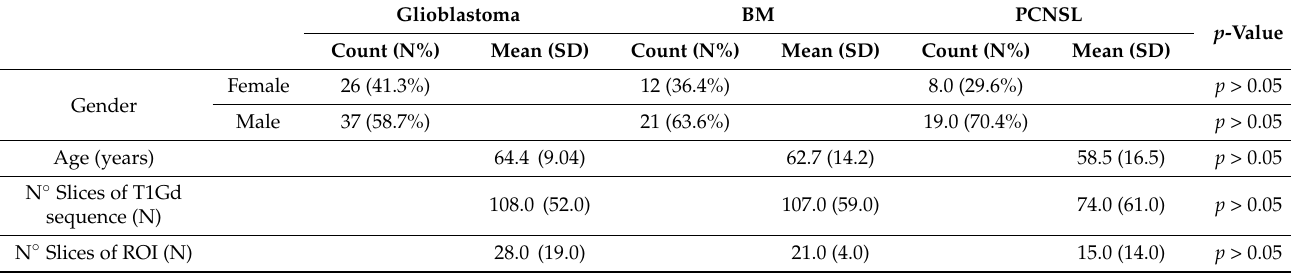
Table 1. Demographics and imaging acquisition